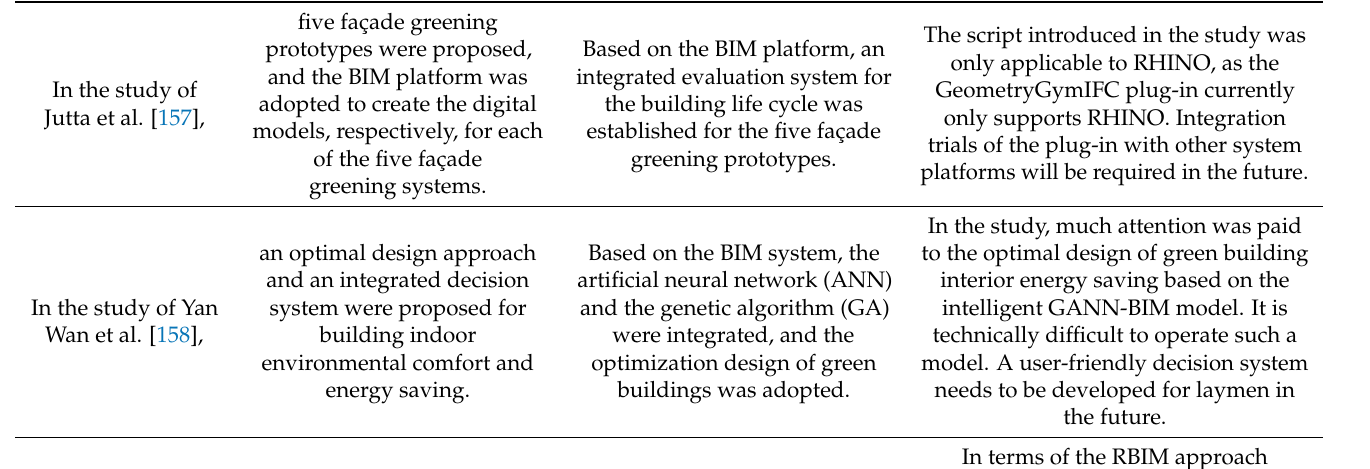
Table 9. Relevant literature based on building energy simulation